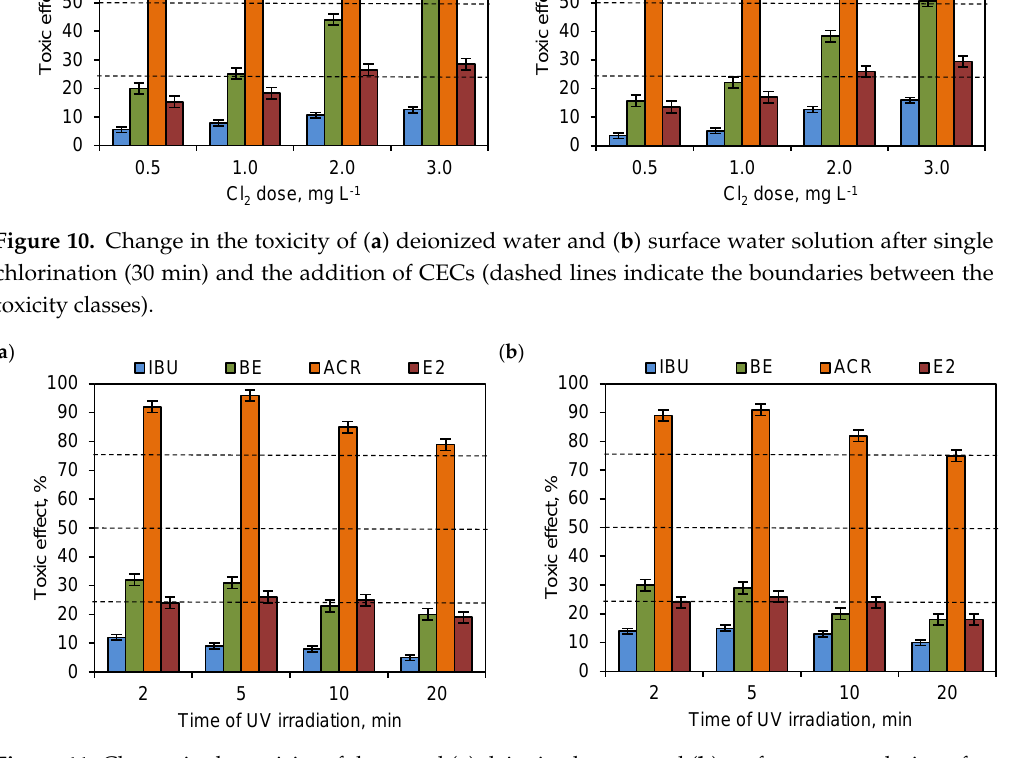
Figure 11. Change in the toxicity of the tested ( a ) deionized water and ( b ) surface water solution after the UV/NaOCl/H 2 O 2 process (dashed lines indicate the boundaries between the toxicity classes).